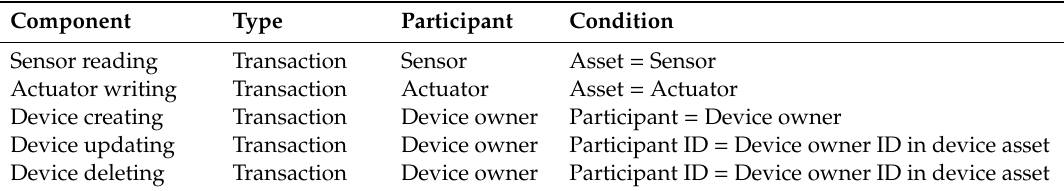
Table 5. Sample transaction definition in the smart contract.